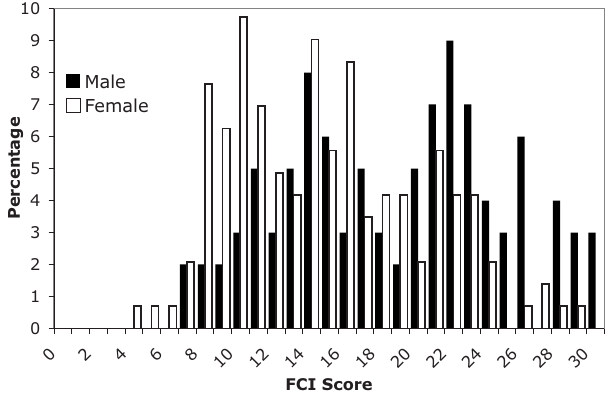
FIG. 2. Distribution of FCI scores for male and female students in the semester